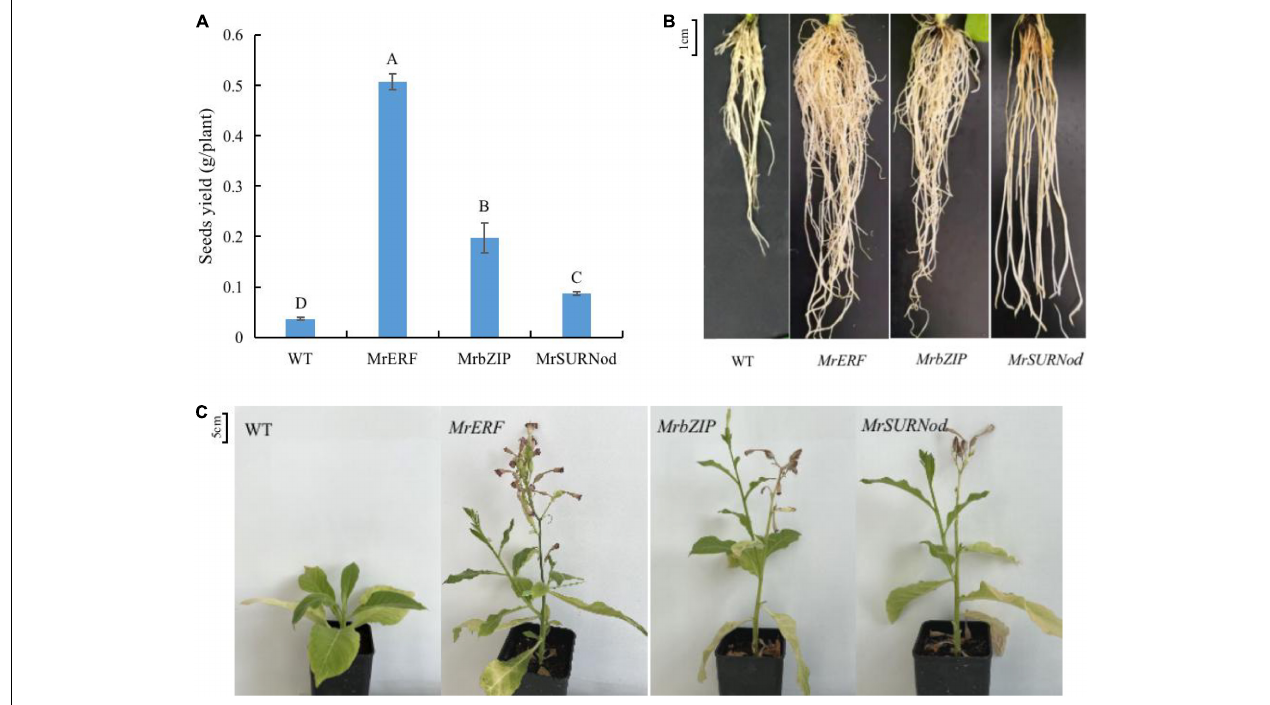
13.92- and 16.45-fold of the control, respectively) on 9th day. By contrast, MrSURNod expression was 2.90 times higher than that